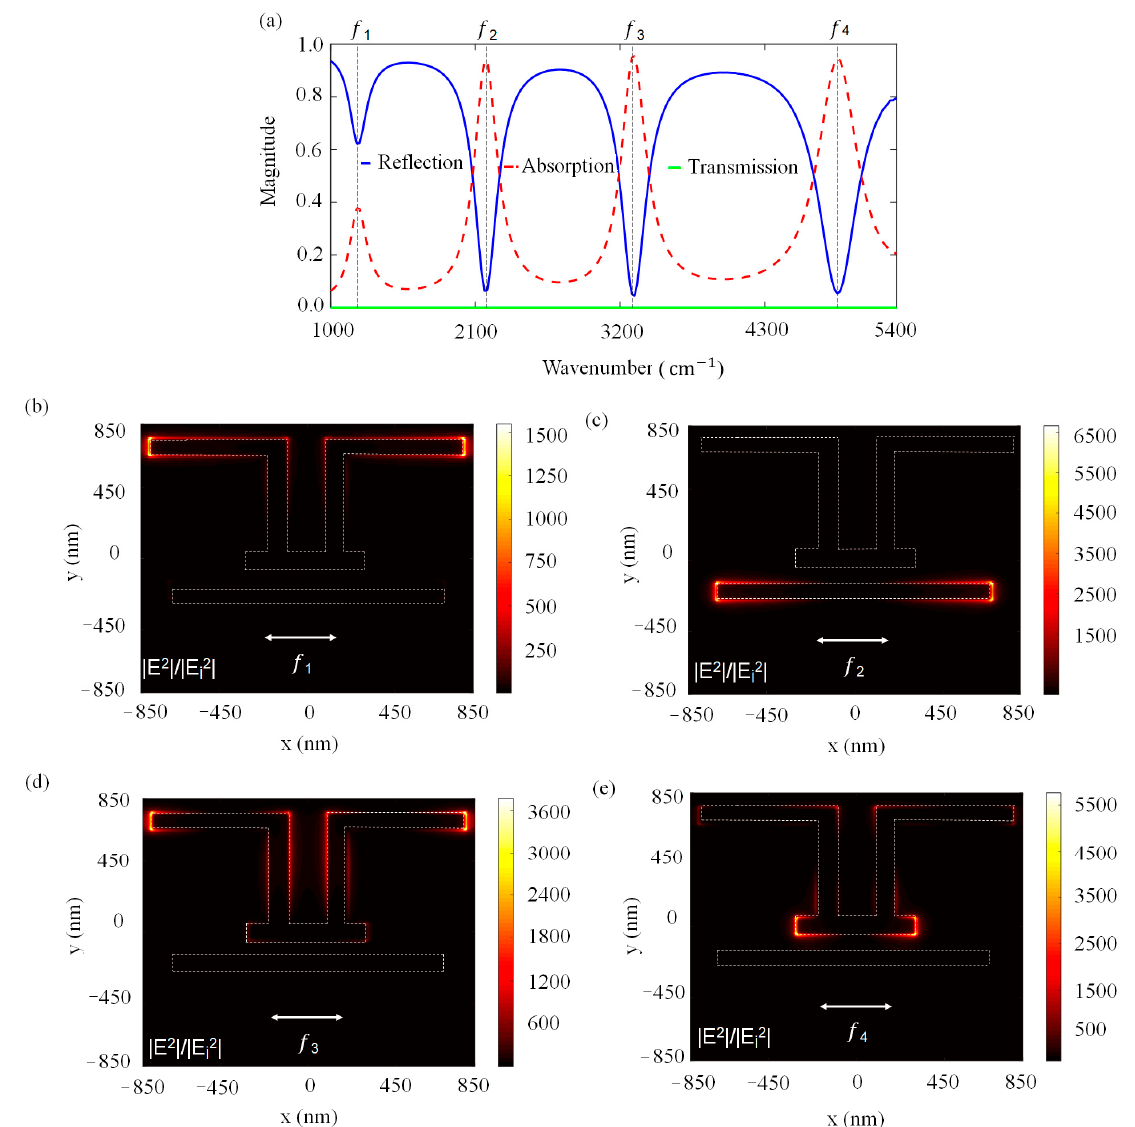
Figure 2. ( a ) Simulated reflection, absorption and transmission spectra of the PA and near-field intensity distributions on Au nanoantennas for: ( b ) the first mode at 1283 cm − 1 , ( c ) the second